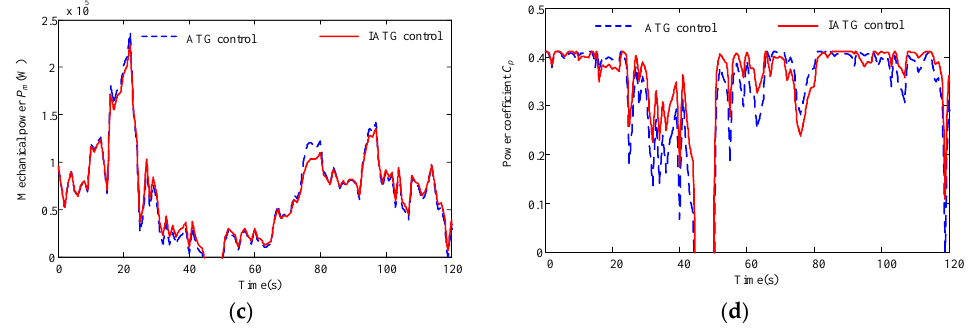
Figure 12. MPPT performances in searching the optimal gains under wind speed with T i of category B: ( a ) K d of ATG and IATG control; ( b ) MPPT efficiency η favg ; ( c ) mechanical power P m ; and ( d ) power coefficient C p .